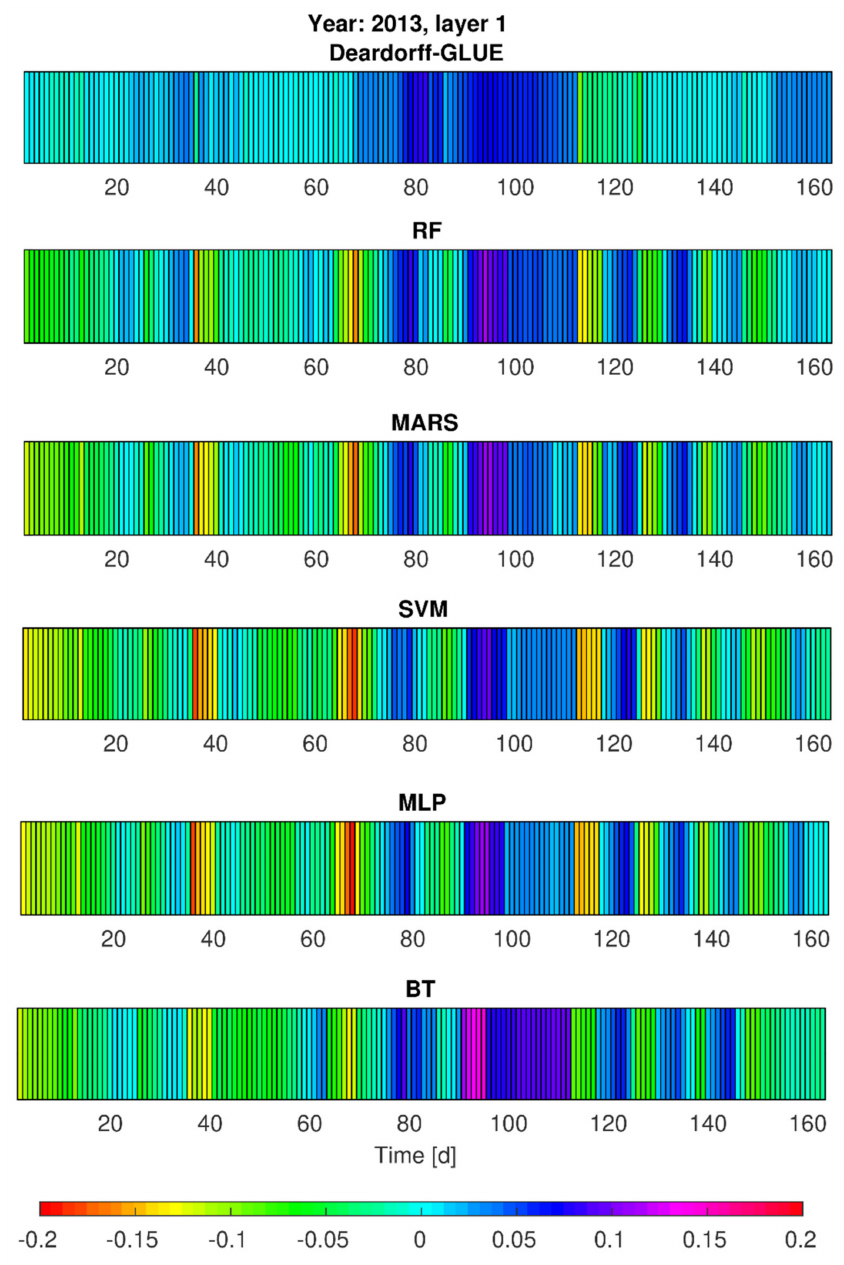
Figure 7. Error variability of soil moisture content forecast ( w 1 , first layer) in 2013 by Deardorff model and statistical methods (BT, RF, SVM, MLP,